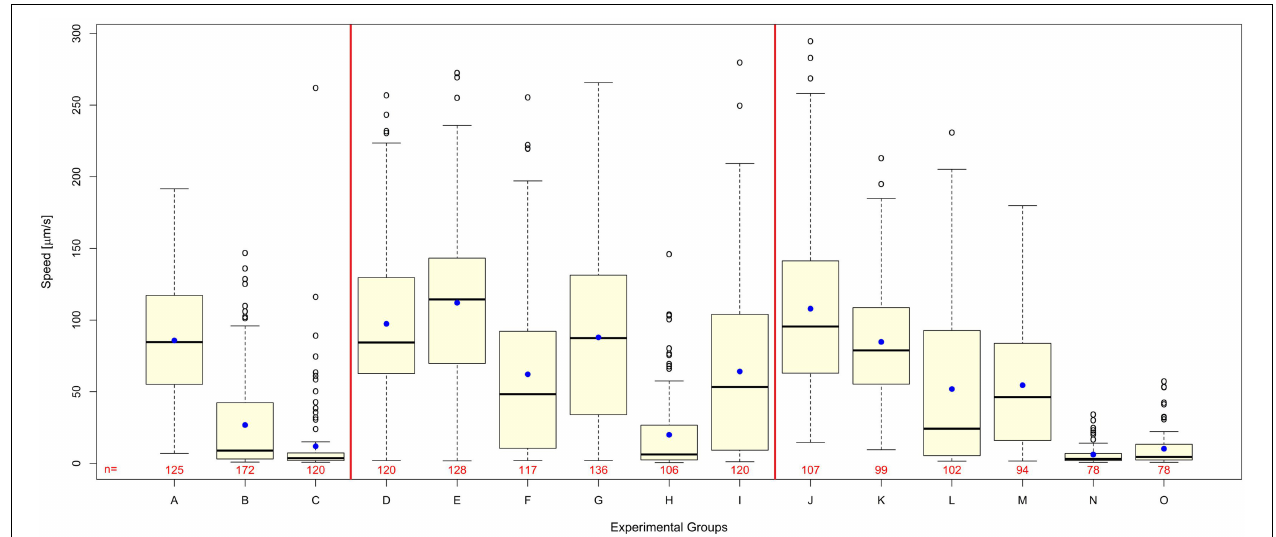
FIGURE 4 | Polyvinyl alcohol reduces shock wave effect on C. elegans , whereas shock wave exposed C. elegans grown on NGM agar plates exhibit similar behavioral change to shock wave exposed C. elegans raised in liquid cultures. (A–C) Worms exposed to 0 (A) , 100 (B) , or 500 (C) shock waves in the main experiment of this study (these data are the same as those shown in Figure 2A and are displayed again here as a comparison only). (D–I) Worms exposed to 0 (D) , 100 (F) , or 500 (H) shock waves in S-Medium, compared to worms exposed to 0 (E) , 100 (G), or 500 (I) shock waves in polyvinyl alcohol, a medium with low cavitation activity. Note that worms exposed to shock waves in polyvinyl alcohol demonstrated higher average worm speed than controls in S-medium ( p < 0 . 001) immediately following application of shock wave. (J–O) Worms raised in liquid cultures and exposed to 0 (J) , 100 (L) , or 500 (N) shock waves in S-Medium, compared to worms grown on NGM agar plates and exposed to